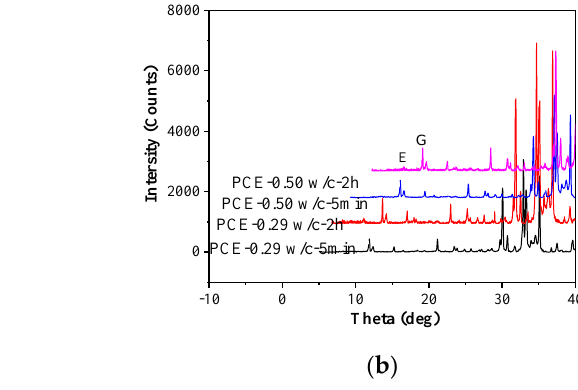
AFt contents in the presence of PCEs were marked in Figure 16b. Samples in